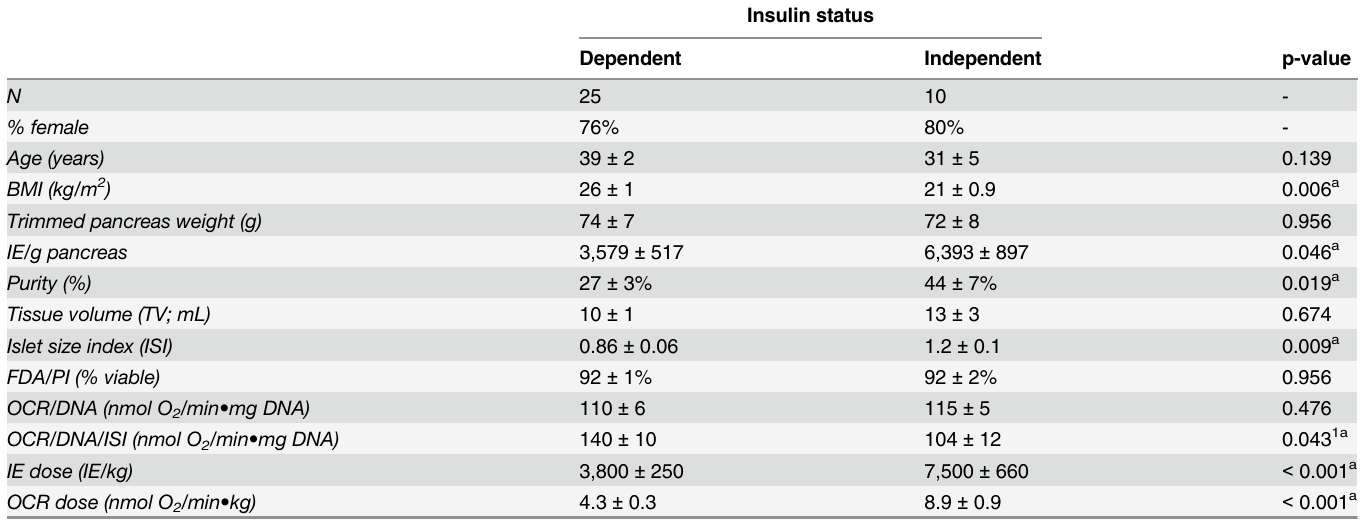
Table 1. Comparison of demographic, isolation, and quality assessment variables between insulin dependent and independent clinical transplant outcome 6 – 12 months